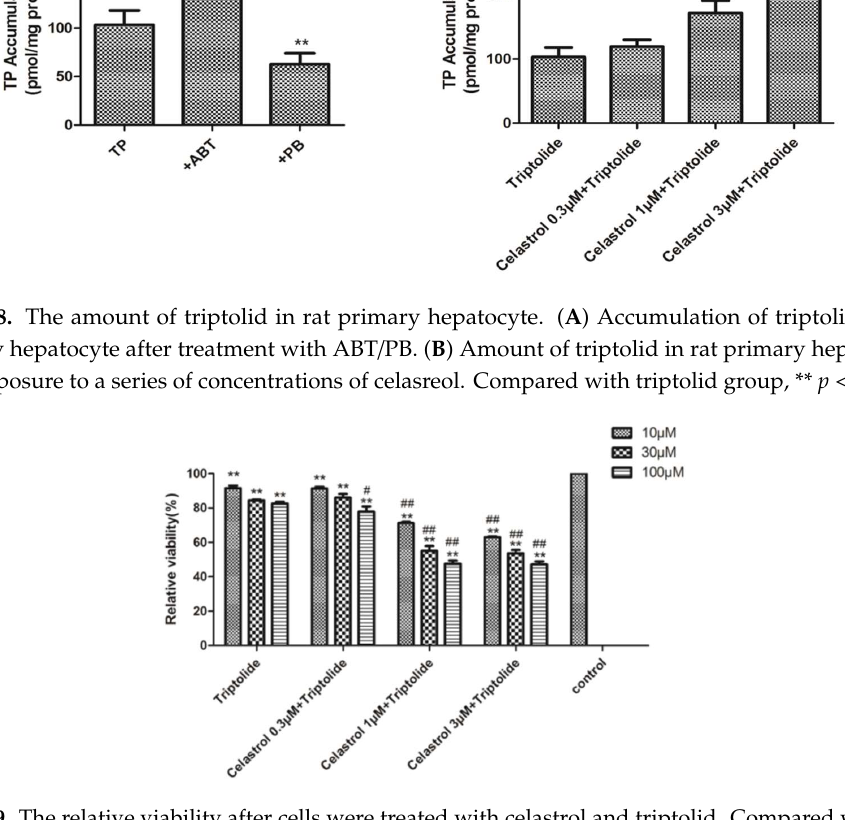
Figure 9. The relative viability after cells were treated with celastrol and triptolid. Compared with the control group, a combination of the two compounds caused cell viability to significantly decrease in a dose-dependent manner; ** p < 0.01. Compared with triptolid group, # p < 0.05, and ## p < 0.01.